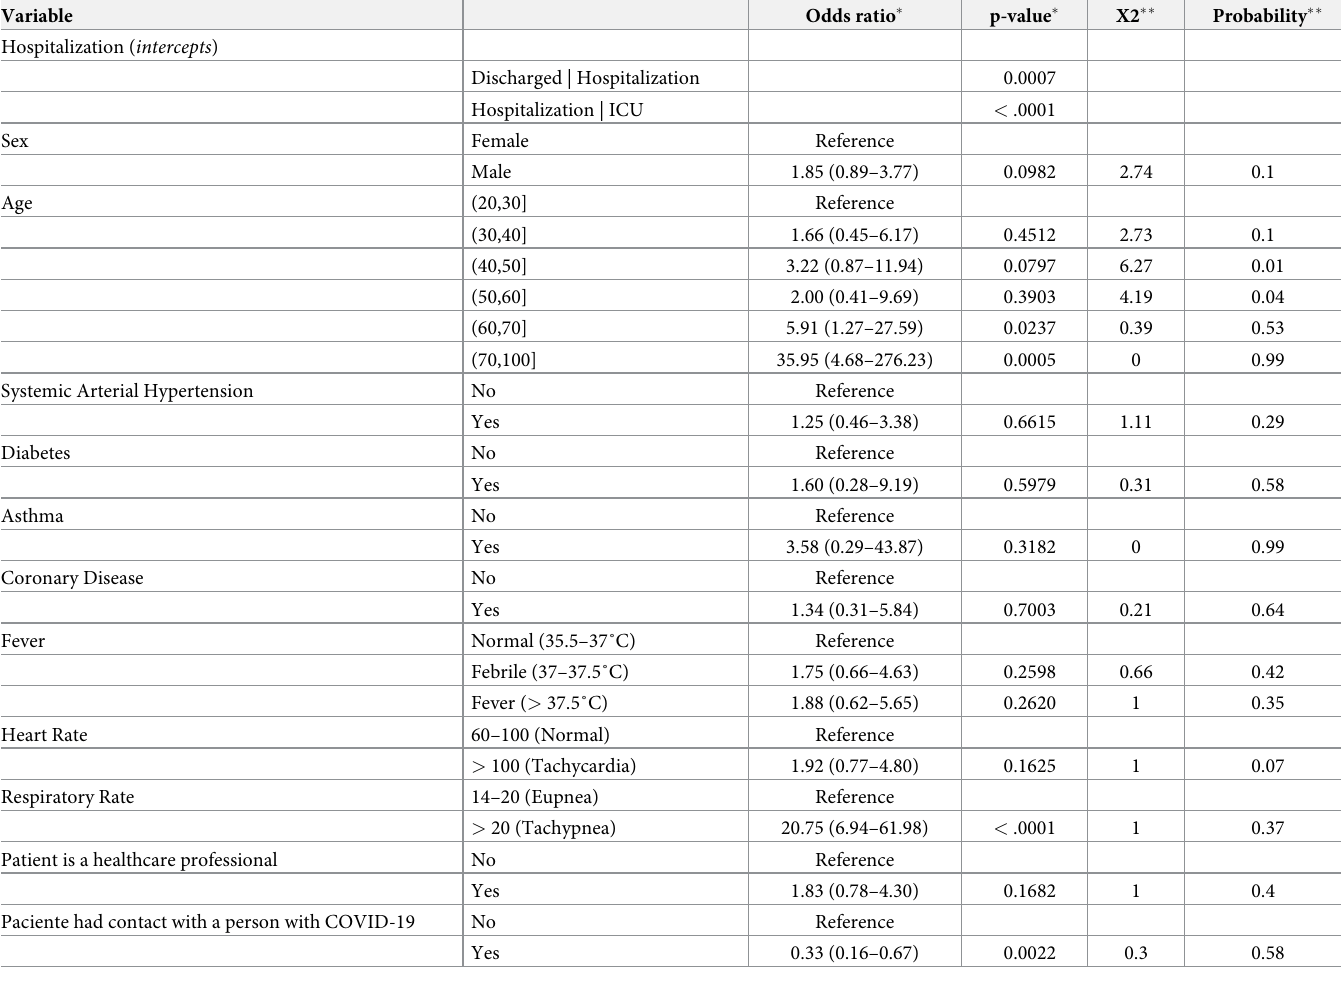
Table 4. Results from ordinal regression of characteristics associated with hospitalization with three levels of response (N = 221). Variable